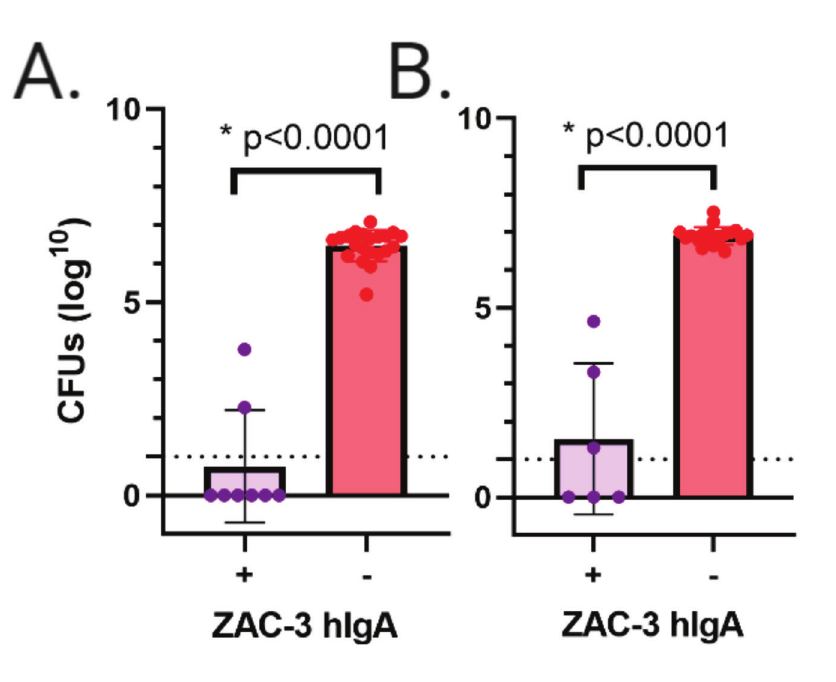
Figure 3. Milk-derived ZAC-3 hIgA1 Reduces Intestinal Colonization of V. cholerae O1. CD-1 pups, 4 to 5 days old, nursed from WT or ZAC-3 hIgA-positive transgenic dams were gavaged with 1 × 10 7 V. cholerae (A) O395 or (B) C6706 cells. After 24 hours incubation pups were euthanized and whole intes- tines were plated for CFUs. There is a significant reduction in log CFUs in pups that were fed from dams secreting ZAC-3 hIgA in comparison to WT dams, for both strains of V. cholerae O1. Experiments were performed on 2 litters for hIgA positive dams, and 6 times on WT dams, with 2 to 4 pups per experimen- tal group, each dot represents the intestinal CFUs of a single pup. Statistical significance was determined using Student’s t -test. P values are indicated on